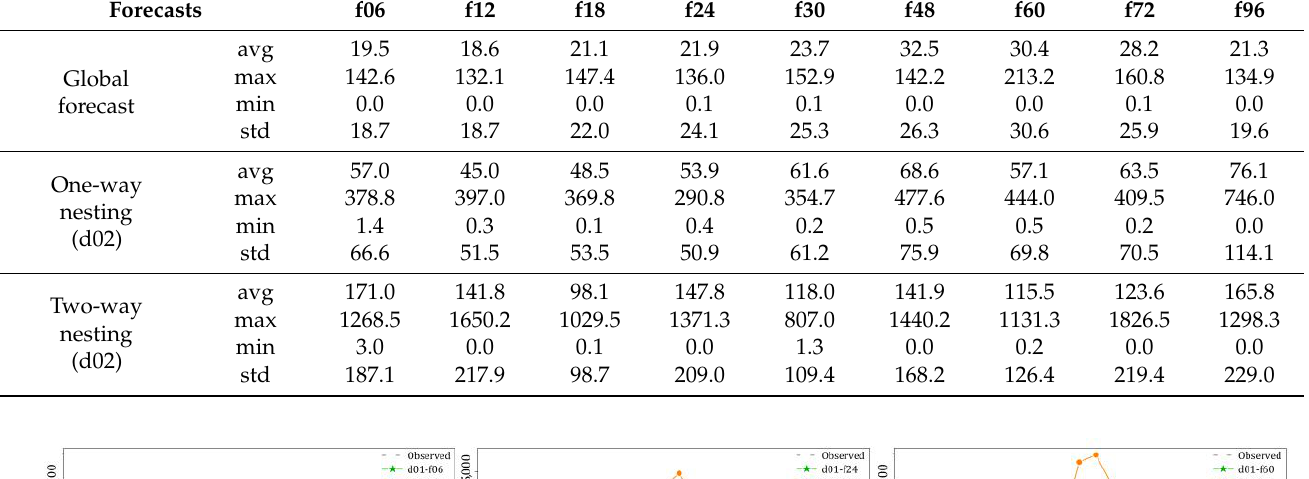
Table 4. Average (avg), minimum (min), maximum (max), and standard deviation (std) for the global